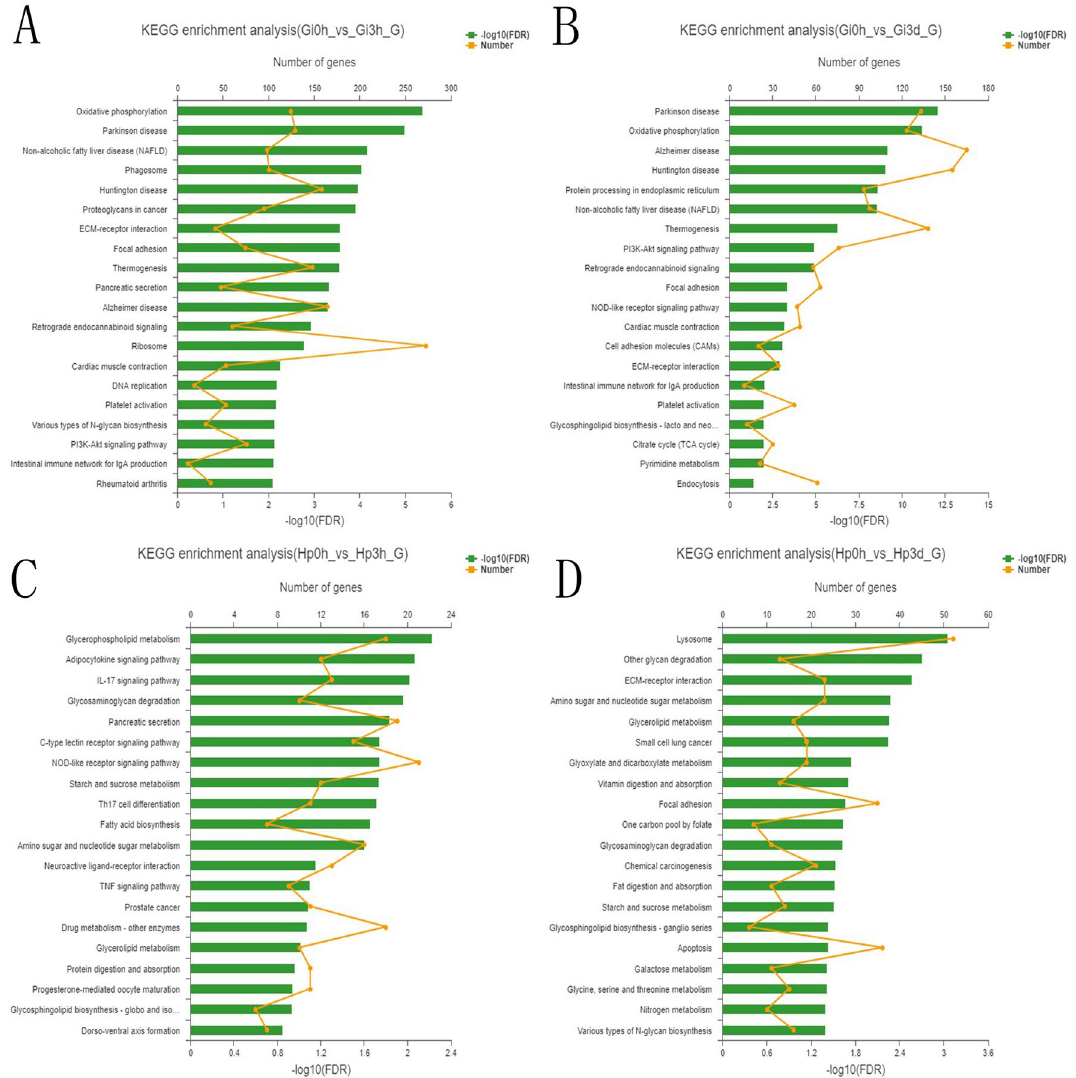
Figure 6. Kyoto Encyclopedia of Genes and Genomes functional analyses of differentially expressed genes between Gi 0 h and Gi 3 h ( a ), Gi 0 h and Gi 3 d ( b ), Hp 0 h and Hp 3 h ( c ), Hp 0 h and Hp 3 d ( d ). The ordinate shows the KEGG metabolic pathway and the broken line represents the number of genes. Gi, gill; HP, hepatopancreas; 0 h, control; 3 h, Cd 2+ treated 3 h; 3d, Cd2 + treated 3 days. (The figures were created based on the KEGG pathway database www. kegg. jp/ kegg/ kegg1.